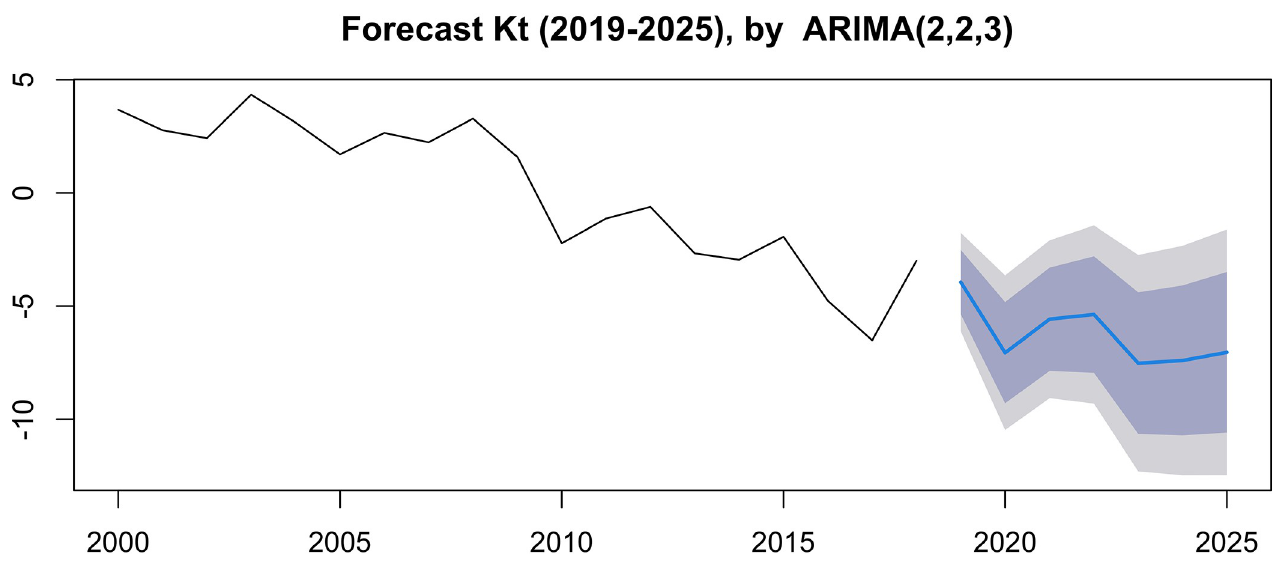
Fig 17. k t , estimated in both sexes (2019–2025), by the ARIMA model (2, 2, 3).